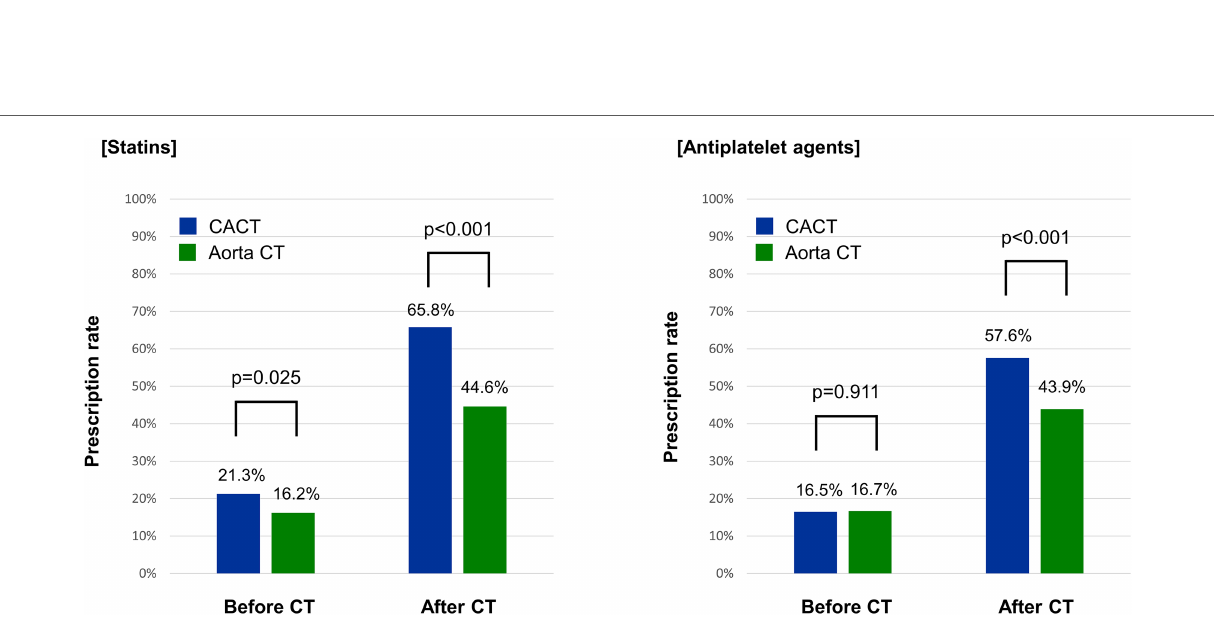
FIGURE 2 Prescription rates of cardiovascular medications before and after CT scan. Aorta CT, thoracoabdominal aorta CT angiography protocol; CACT, coronary- aorta CT protocol; CT, computed